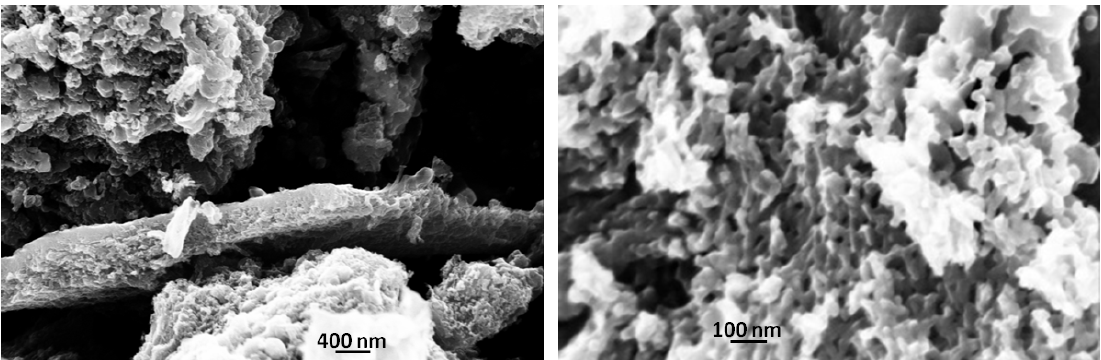
Figure 4. SEM images of BIO04i at different magnification.